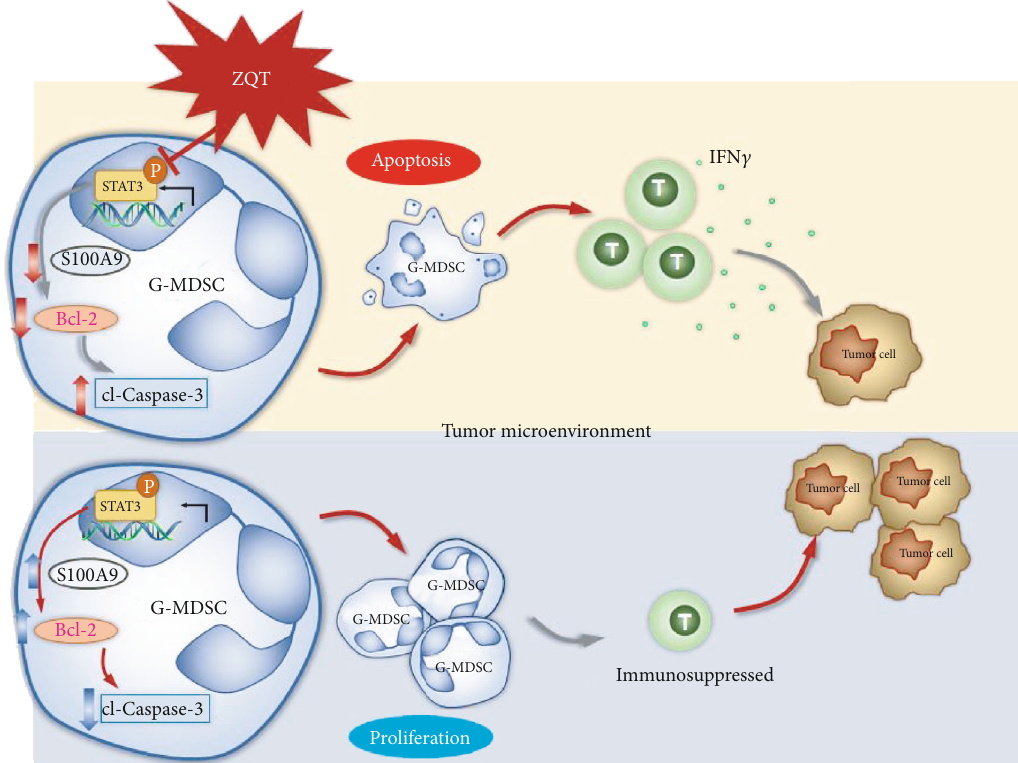
Figure 8: The immune regulatory activity of TCM formula ZQT in TME. ZQT induces the apoptosis of G-MDSCs via the STAT3/S100A9/Bcl-2/caspase-3 signaling pathway, resulting in a signi fi cant decrease in G-MDSCs and their immunosuppressive activity, consequently promoting the in fi ltration and killing activity of CD8 + T cells, leading to the inhibition of the proliferation of tumor